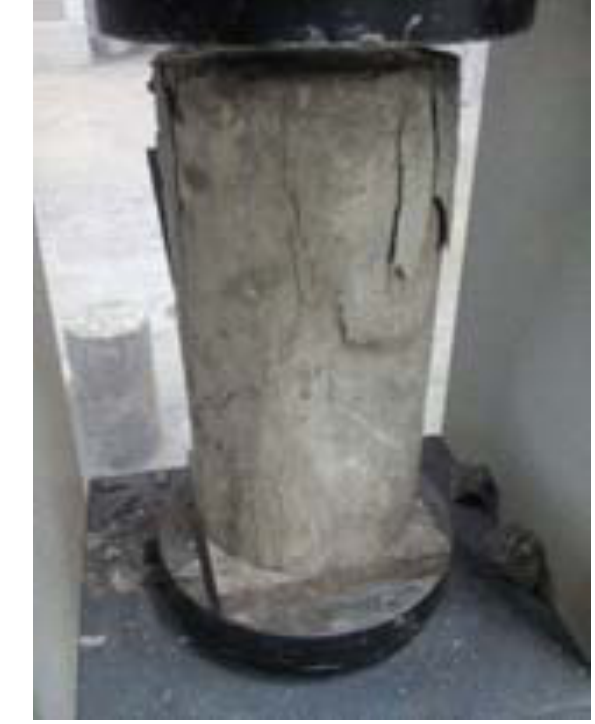
FIG. 6. CRUSHING FAILURE (UOL LAB)